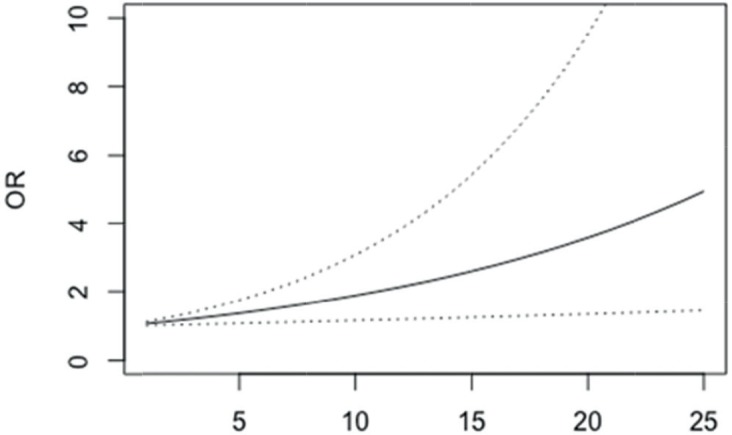
OR of not having depression relative to having depression in patients with differences in QOL scores between 1 and 25 points (95% confidence bands for the OR are shown in dash lines).